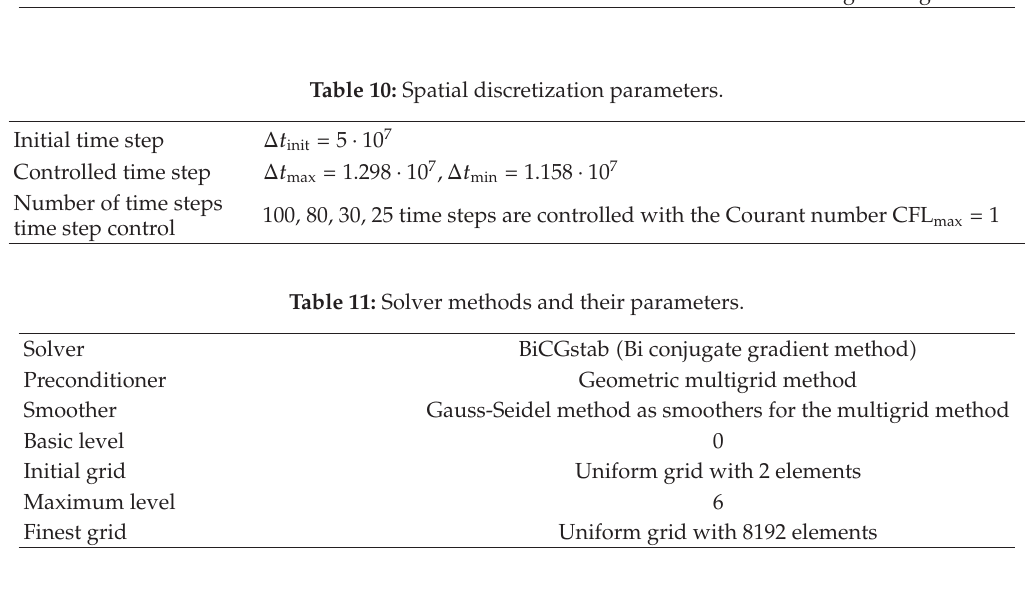
Table 12: L 2 -norm of the solution with refinements and CPU